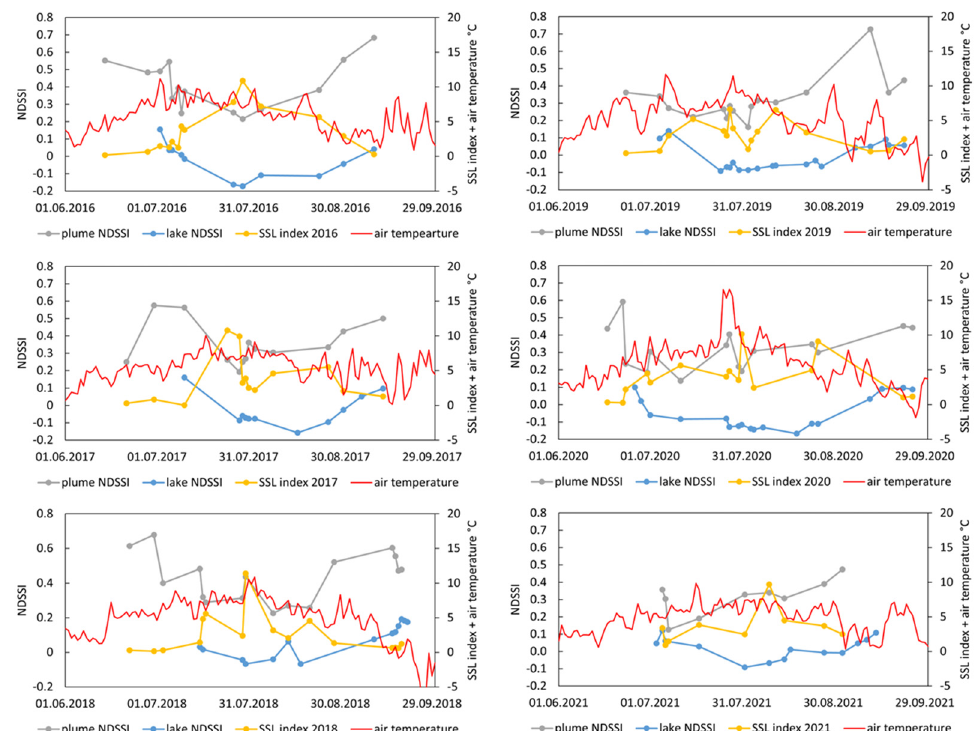
Figure 3. Seasonal dynamics of suspended sediment parameters and air temperature for each year in the period 2016–2021.